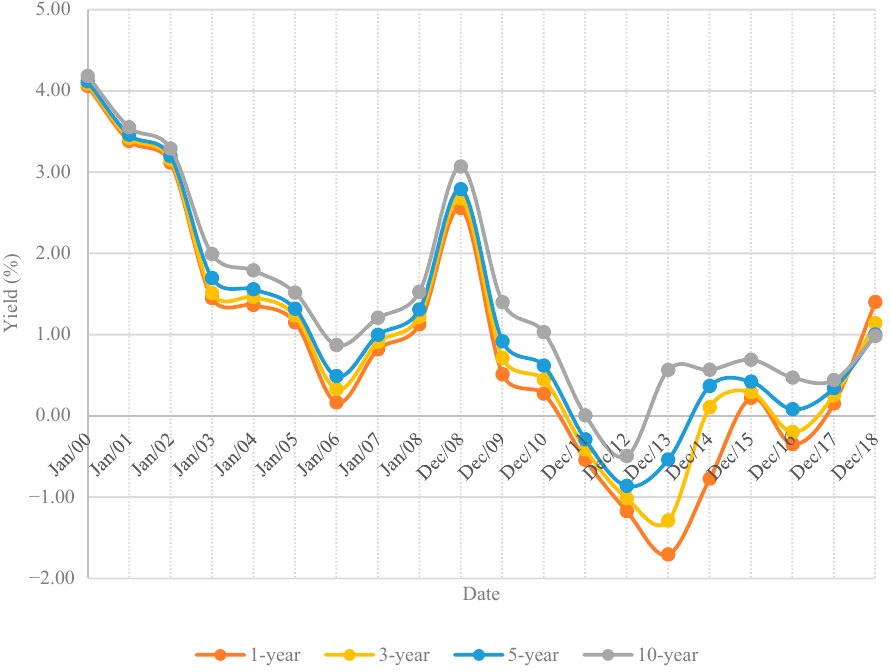
Figure 2. U.S. TIPS Interest